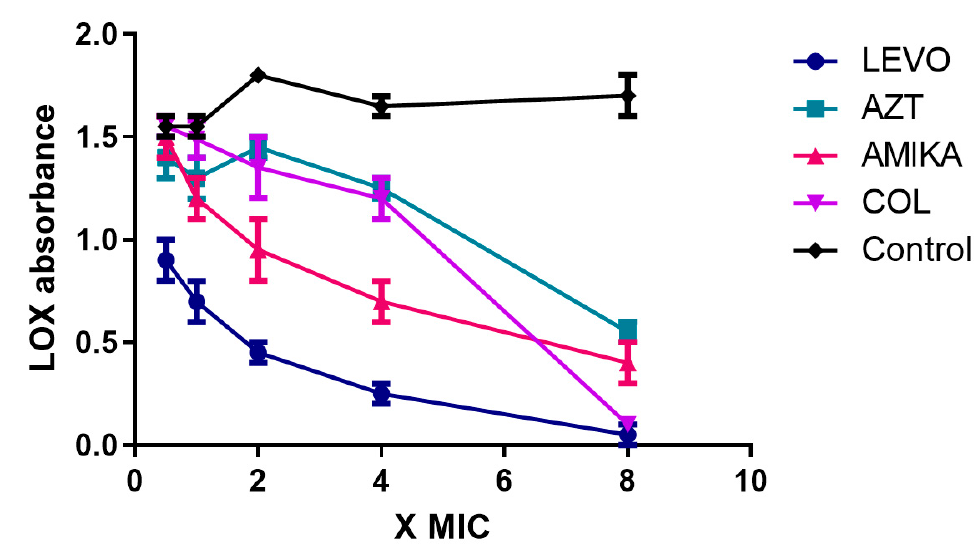
Figure 3. Effects of levofloxacin, aztreonam, amikacin, and colistin on the LOX activity of a clinically isolated strain of P. aeruginosa with high LOX activity. Antibiotics were tested at increasing concen- trations (0.5- to 8-fold the MICs). (LEVO = levofloxacin, AZT = aztreonam, AMIKA = amikacin, COL = colistin, Control = untreated